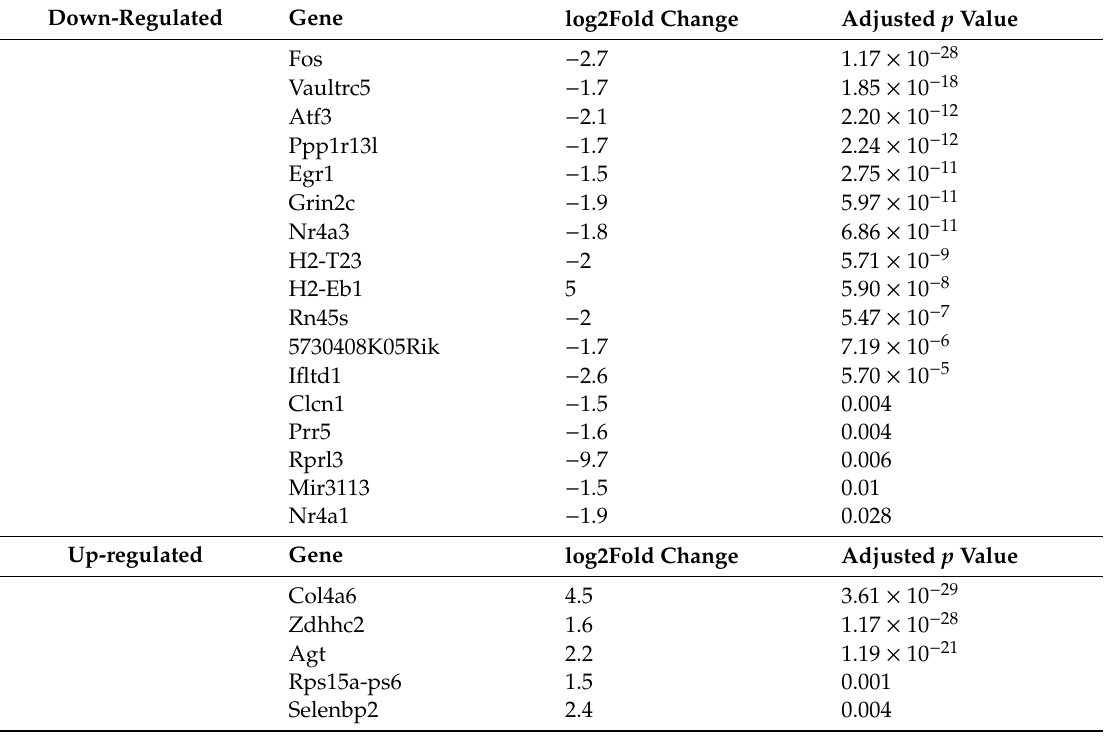
Table 1. Changes in gene expression due to acute SERCA2a overexpression in CASQ2 KO hearts.